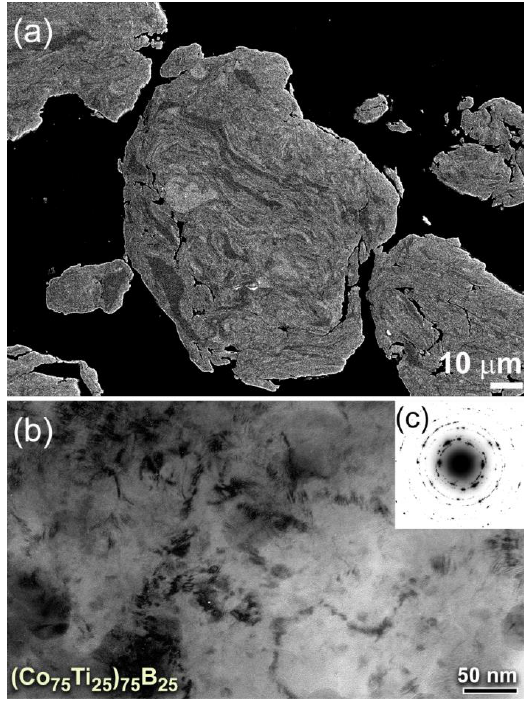
Figure 2. ( a ) FE-SEM micrograph of the cross-sectional view for (Co 75 Ti 25 ) 75 B 25 powders obtained after 18 h of MA time. The corresponding bright-field image (BFI) and selected area diffraction pattern (SADP) of the powders after this stage of MA are displayed in ( b ) and ( c ), respectively. With further MA time (50 h), the powders were disintegrated into finer particles (Figure 3a,b), where the internal structure of the powders continues to be refined. After 50 h of MA time, the lamella-like metallography completely disappeared, as shown in the high-magnification FE-SEM presented in Figure 3a. This implies the completion of the MA process and the formation of a single homogeneous phase. The powders of this final product possessed desirable morphological characteristics of being ultrafine (ranged from 120 nm to 250 nm in diameter) and had spherical-like morphology with smooth surfaces, as displayed in Figure 3b. The field emission high-resolution transmission electron microscope (FE-HRTEM) image of the final product obtained after 50 h of MA time (Figure 3c) revealed featureless maze-like morphology of an amorphous phase. Besides, the corresponding nanobeam diffraction pattern (NBDP) showed a typical amorphous-like halo-diffuse pattern, as displayed in Figure 3d.